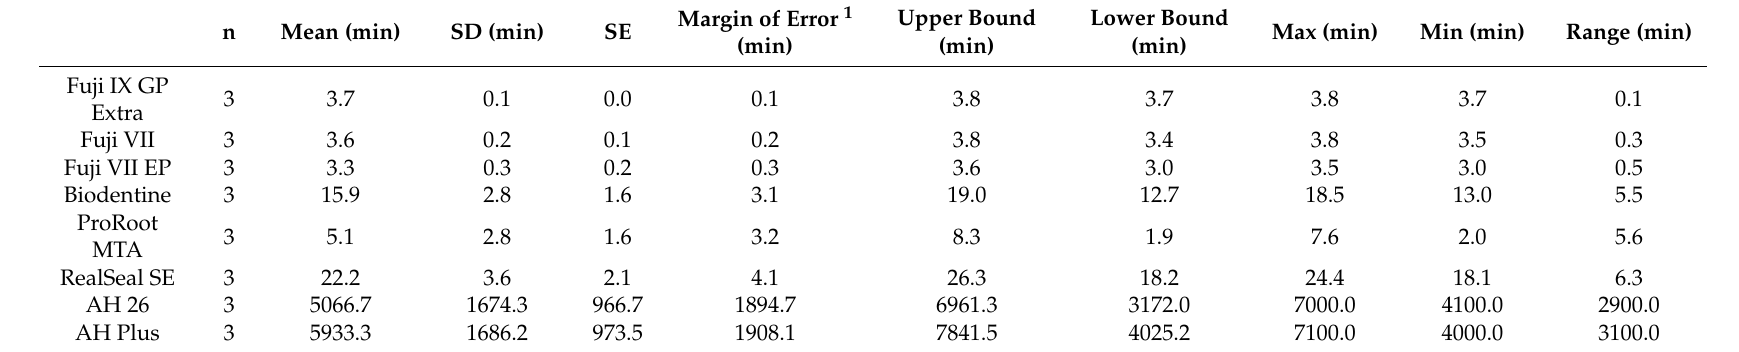
1 Confidence coefficient is set at 1.96. SD: Standard deviation; SE: Standard error. Table 2. Time to reach 90% of the plateau elastic modulus (in